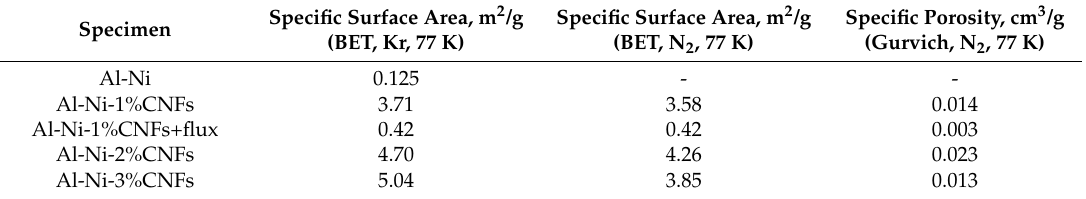
Table 1. Specific surface and porosity of aluminum/carbon nanofibers (CNFs) samples.